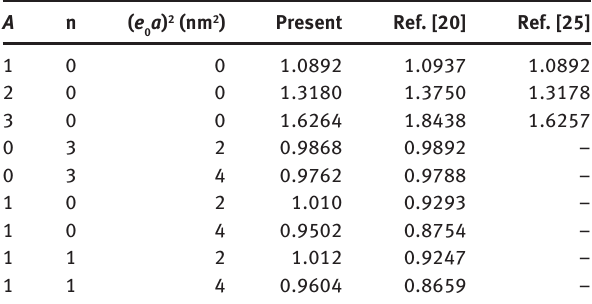
Table 2: Comparison of nonlinear natural frequencies to classical linear natural frequency ratio of FG nanobeams.